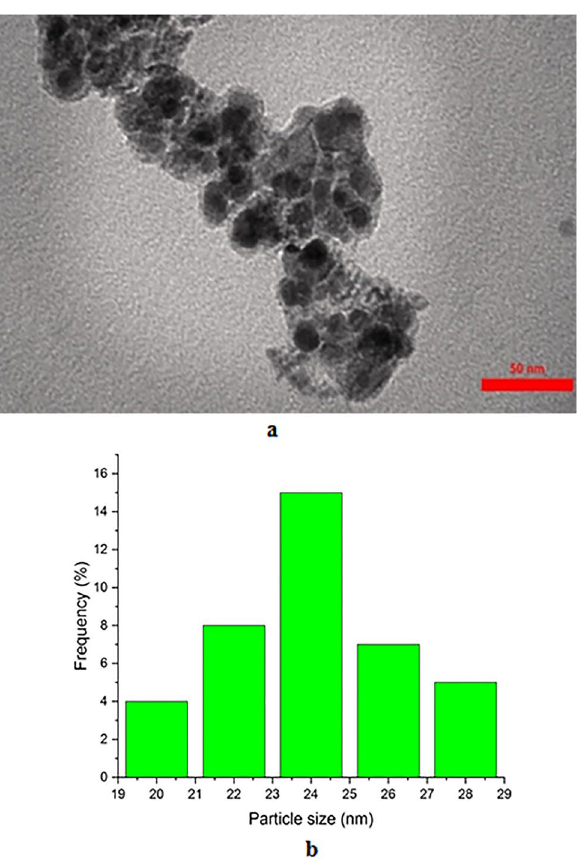
Figure 7. ( a ) TEM image (scale bar at 50 nm) and ( b ) histogram of Fe 3 O 4 @SiO 2 -Im[Br]-SB-Cu (II) nano-